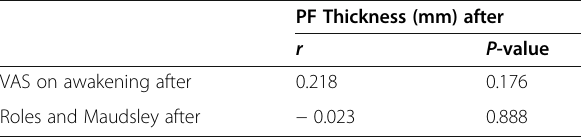
Table 4 Correlation of PF thickness after with VAS on awakening after and Roles and Maudsley after PF Thickness (mm)